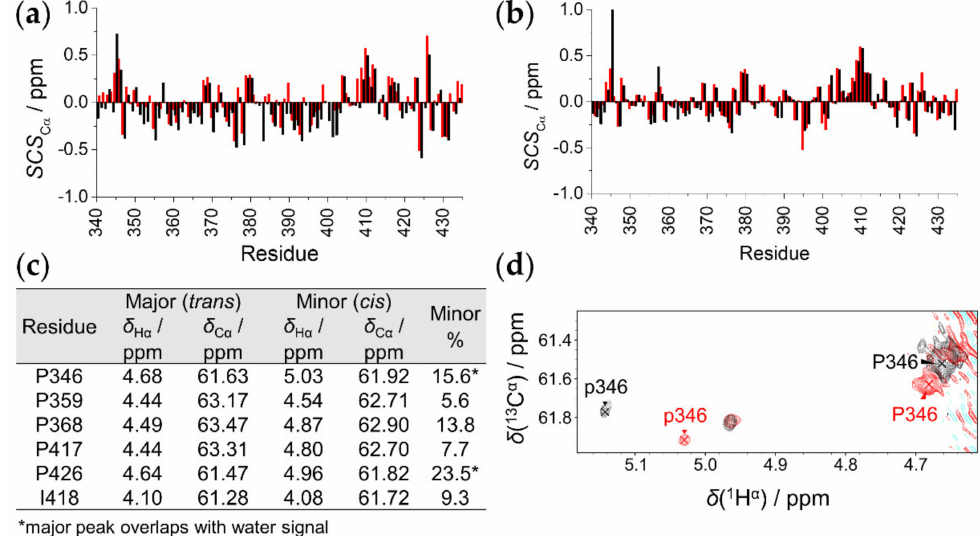
Figure 4. Comparison of EZH2 wt and EZH2 T345D : ( a , b ) SCS C α values of EZH2 wt (red) and EZH2 T345D (black). Random coil values were calculated according to Kjaergaard et al. ( a ) and with POTENCI ( b ). ( c ) Determined cis / trans Pro conformers with chemical shifts and percentage of minor conformer indicated. ( d ) Proline region of the SHACA-HSQC spectrum of EZH2 wt (red) and T345D mutant (black) at 310 K. p346 refers to the minor signal of